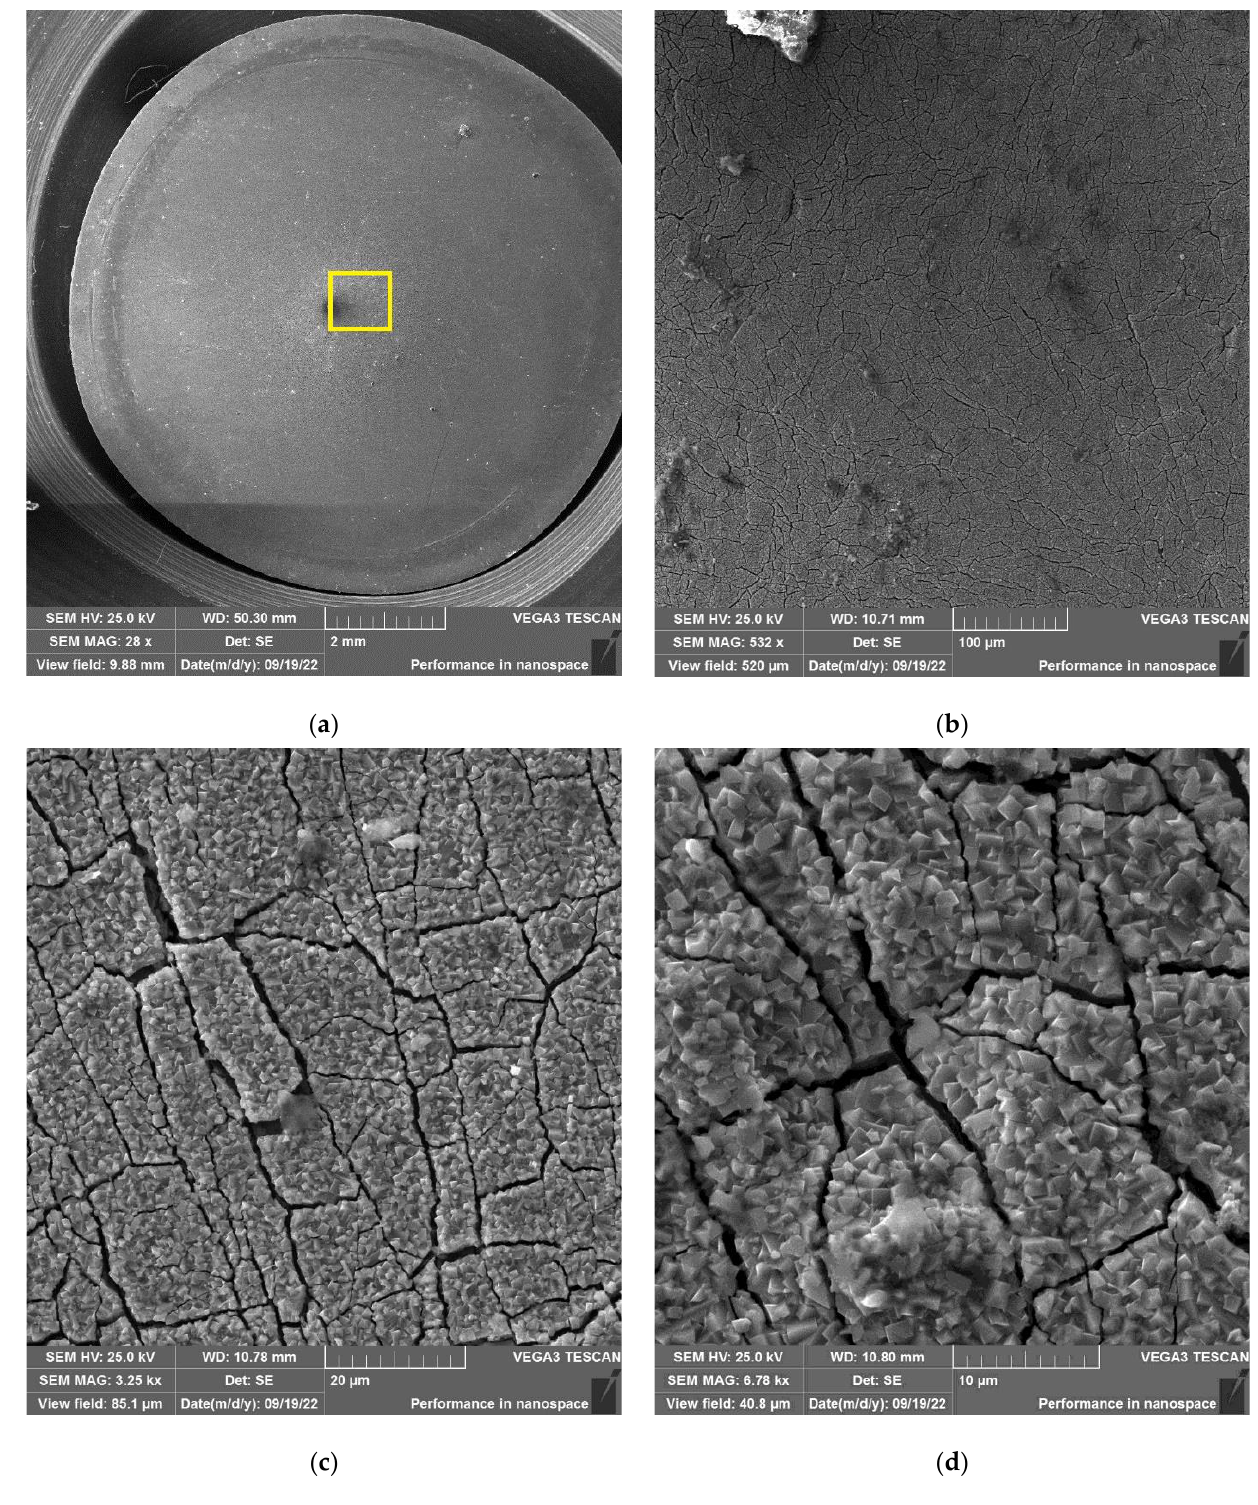
Figure 17. Surface of disk specimen № 7 (T irr = 390 °C, Table 4) at different magnifications after autoclave SCC tests with a load value of 423 N and additional loading up to 6023 N.